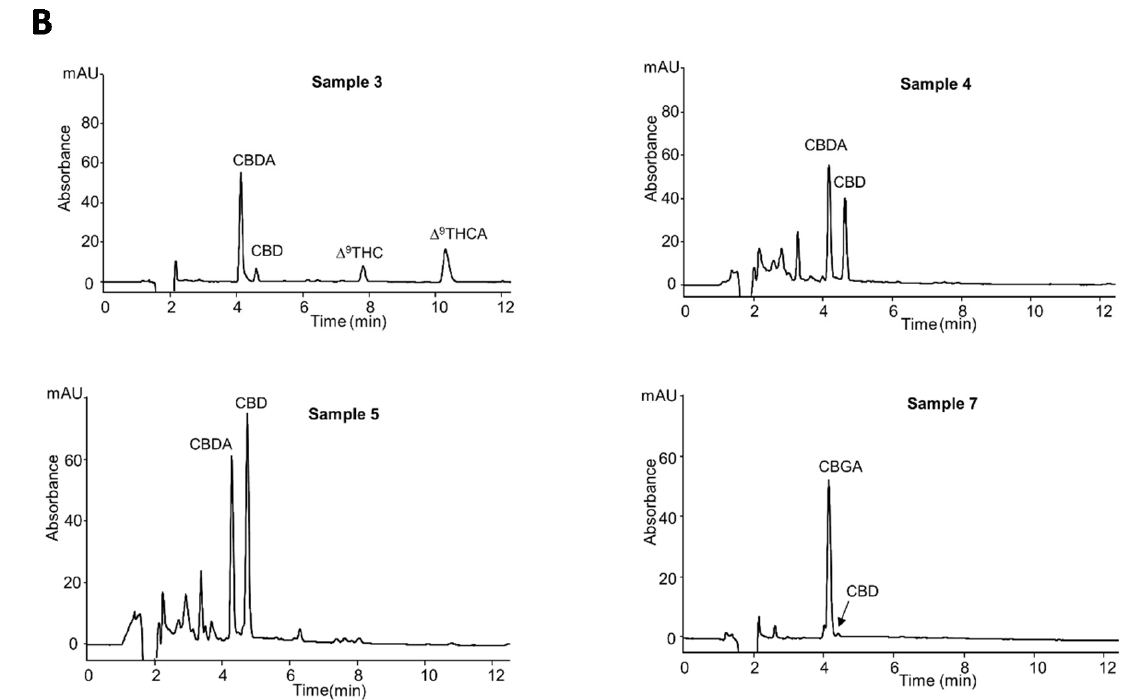
Figure 4. ( A , B ) Nano-LC-UV profiles of the hemp extracts. Experimental conditions: capillary columns (100 µ m × 15 cm) packed with ChromSpher C18 dp 3 µ m; mobile phase, ACN/H 2 O/formic acid, 80/19/1% ( v / v / v ). UV detection, 214 nm; injection time, 30 s; flow rate, 550. The samples here reported, were subjected to a dynamic maceration (DM) extraction procedure, with the exception of samples 4 and 5, which were subjected to the hydro-alcoholic extraction procedure (HAE).